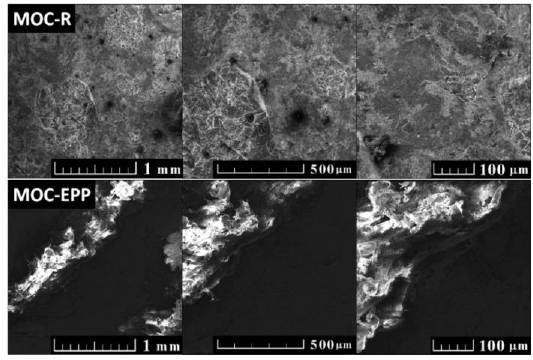
Figure 7. SEM micrographs of MOC-R and MOC-EPP at various magnifications.